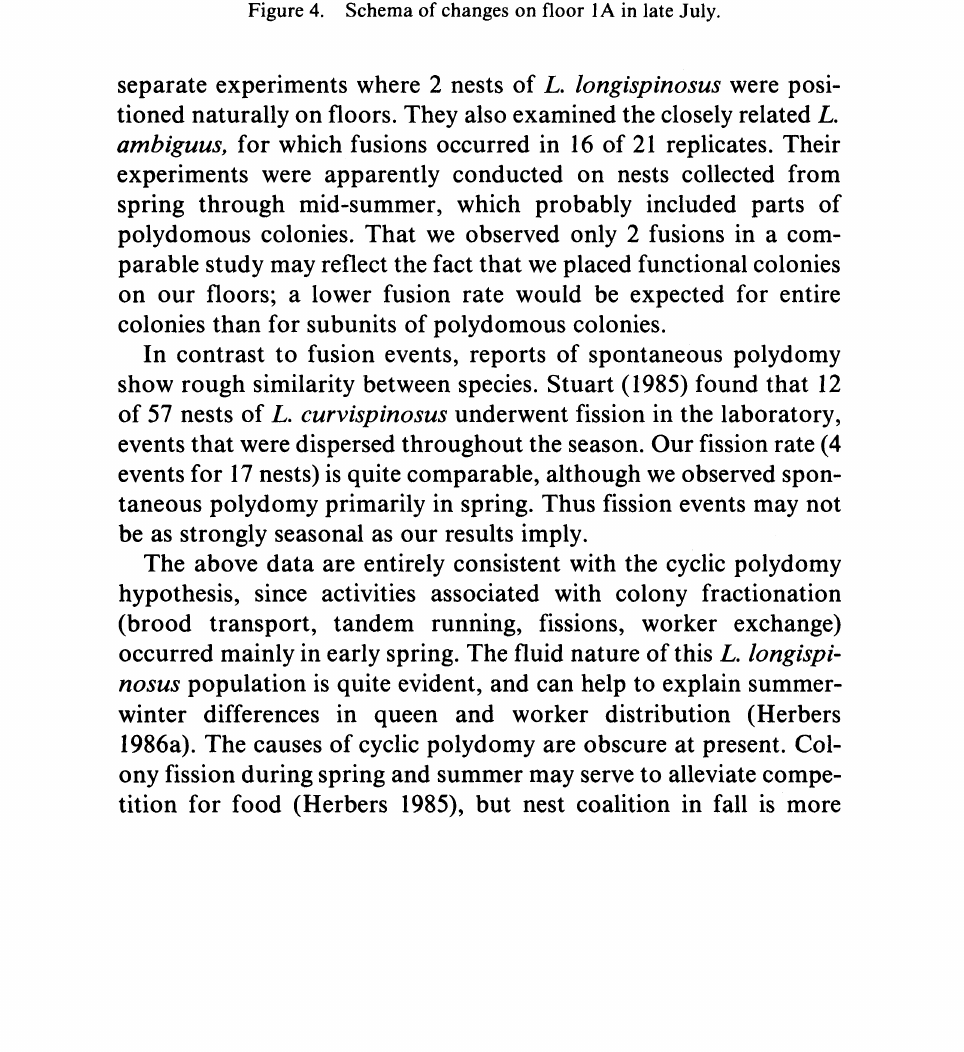
Figure 4. Schema of changes on floor IA in late